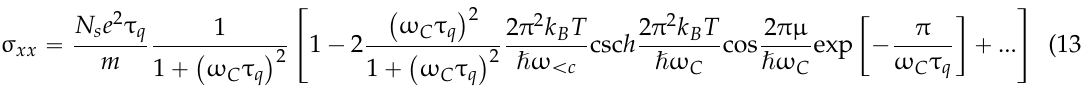
Figure 10. Transversal and longitudinal source drain resistivity ( Δ R/R) as a function of the inverse magnetic field B. Measurement on a nMOSFET with a dislocation network (V D = 3 V) at 3.1 K.